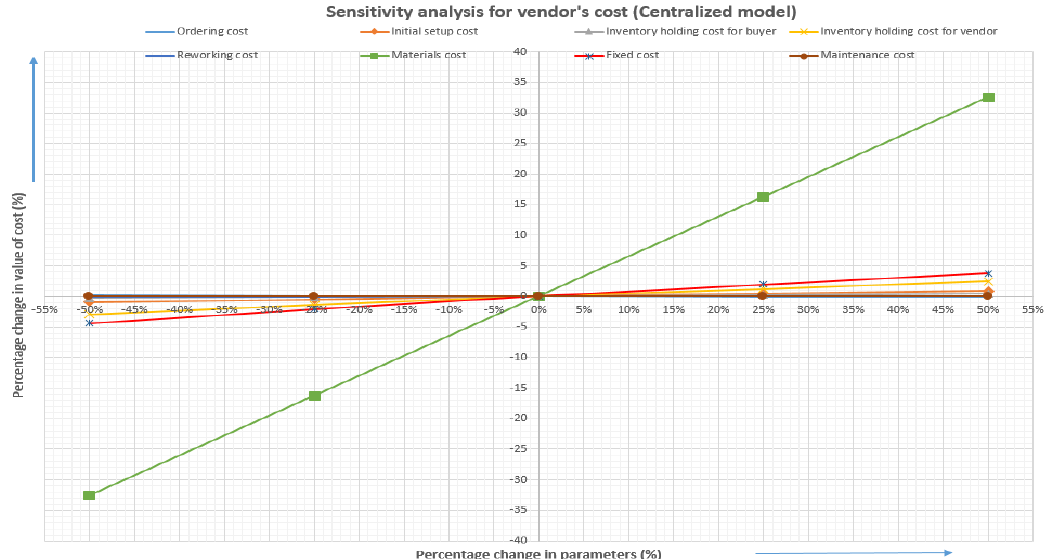
Figure 5. Sensitivity analysis: total cost versus change in parameters under centralized